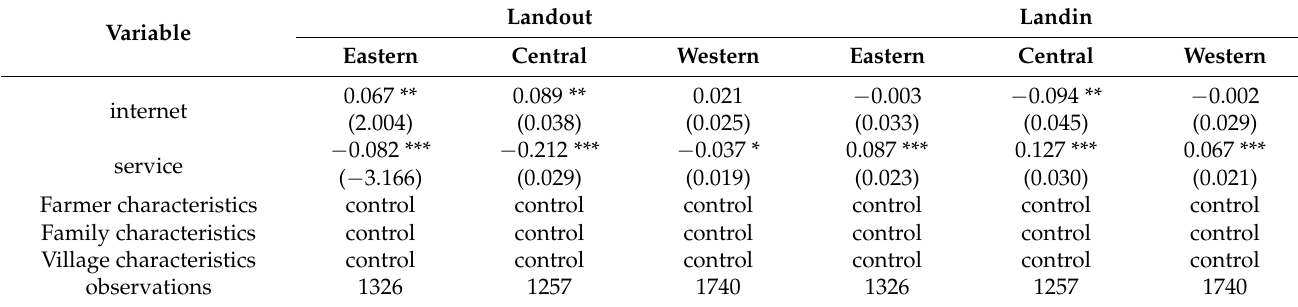
Table 4. Heterogeneity Analysis of Farmers Grouped by